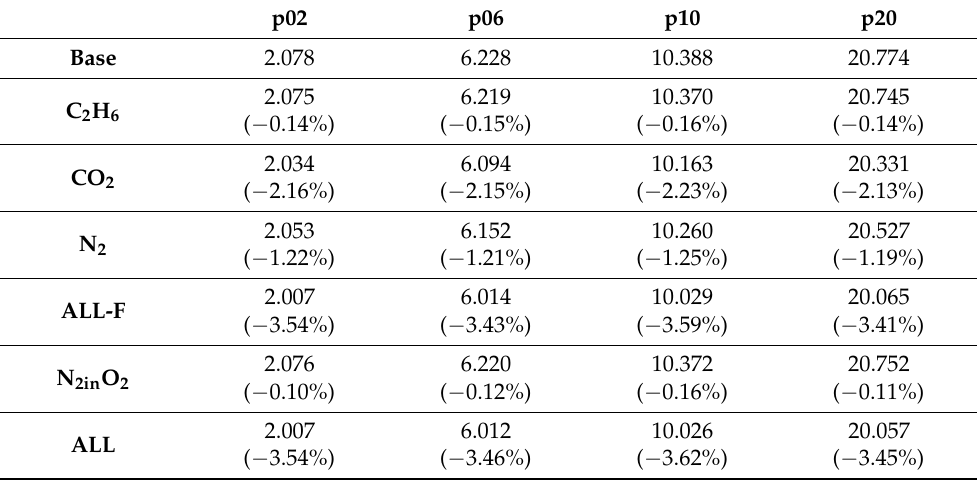
( d ) Figure 10. Combustion chamber wall pressure for different pollutants of the fuel and/or oxidizer at the combustion chamber configuration: ( a ) p02 (target pressure 2 MPa), ( b ) p06 (target pressure 6 MPa), ( c ) p10 (target pressure 10 MPa), and ( d ) p20 (target pressure 20 MPa).